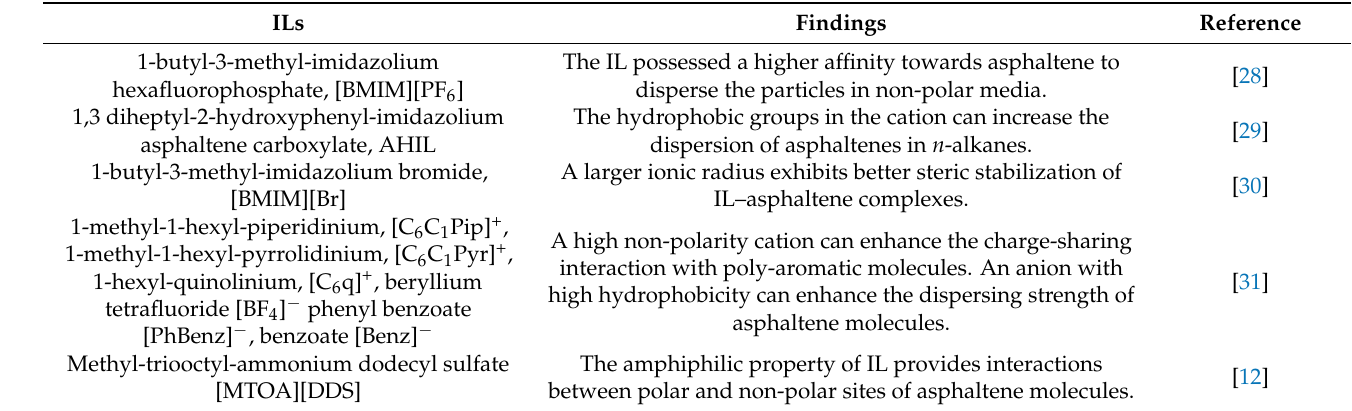
Table 1. ILs used for petroleum asphaltene